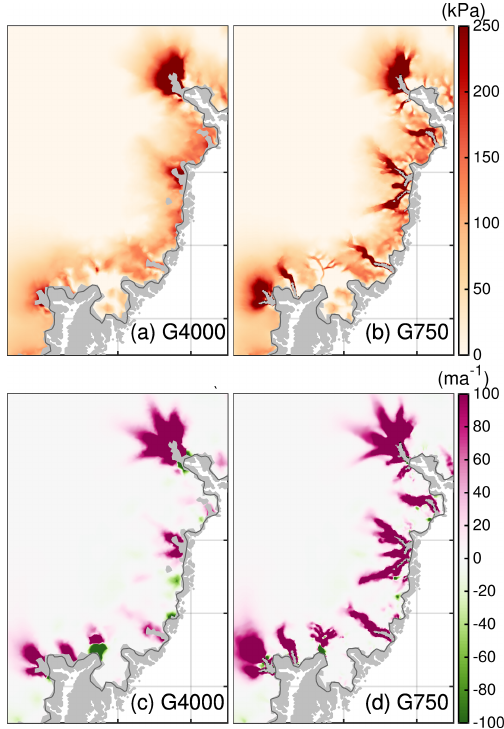
Figure 12. (a, b) Difference in effective pressure between 2100 and 2015 for the southeast region. (c, d) Difference in basal velocity be- tween 2100 and 2015 for the southeast region. Region subsets are shown in Fig. 2. Dark grey line indicates the initial ice extent. Thin black line indicating the grounding line is not visible as it falls to- gether with the calving front. The grey silhouette shows the Green- land land mask from BedMachine v3.